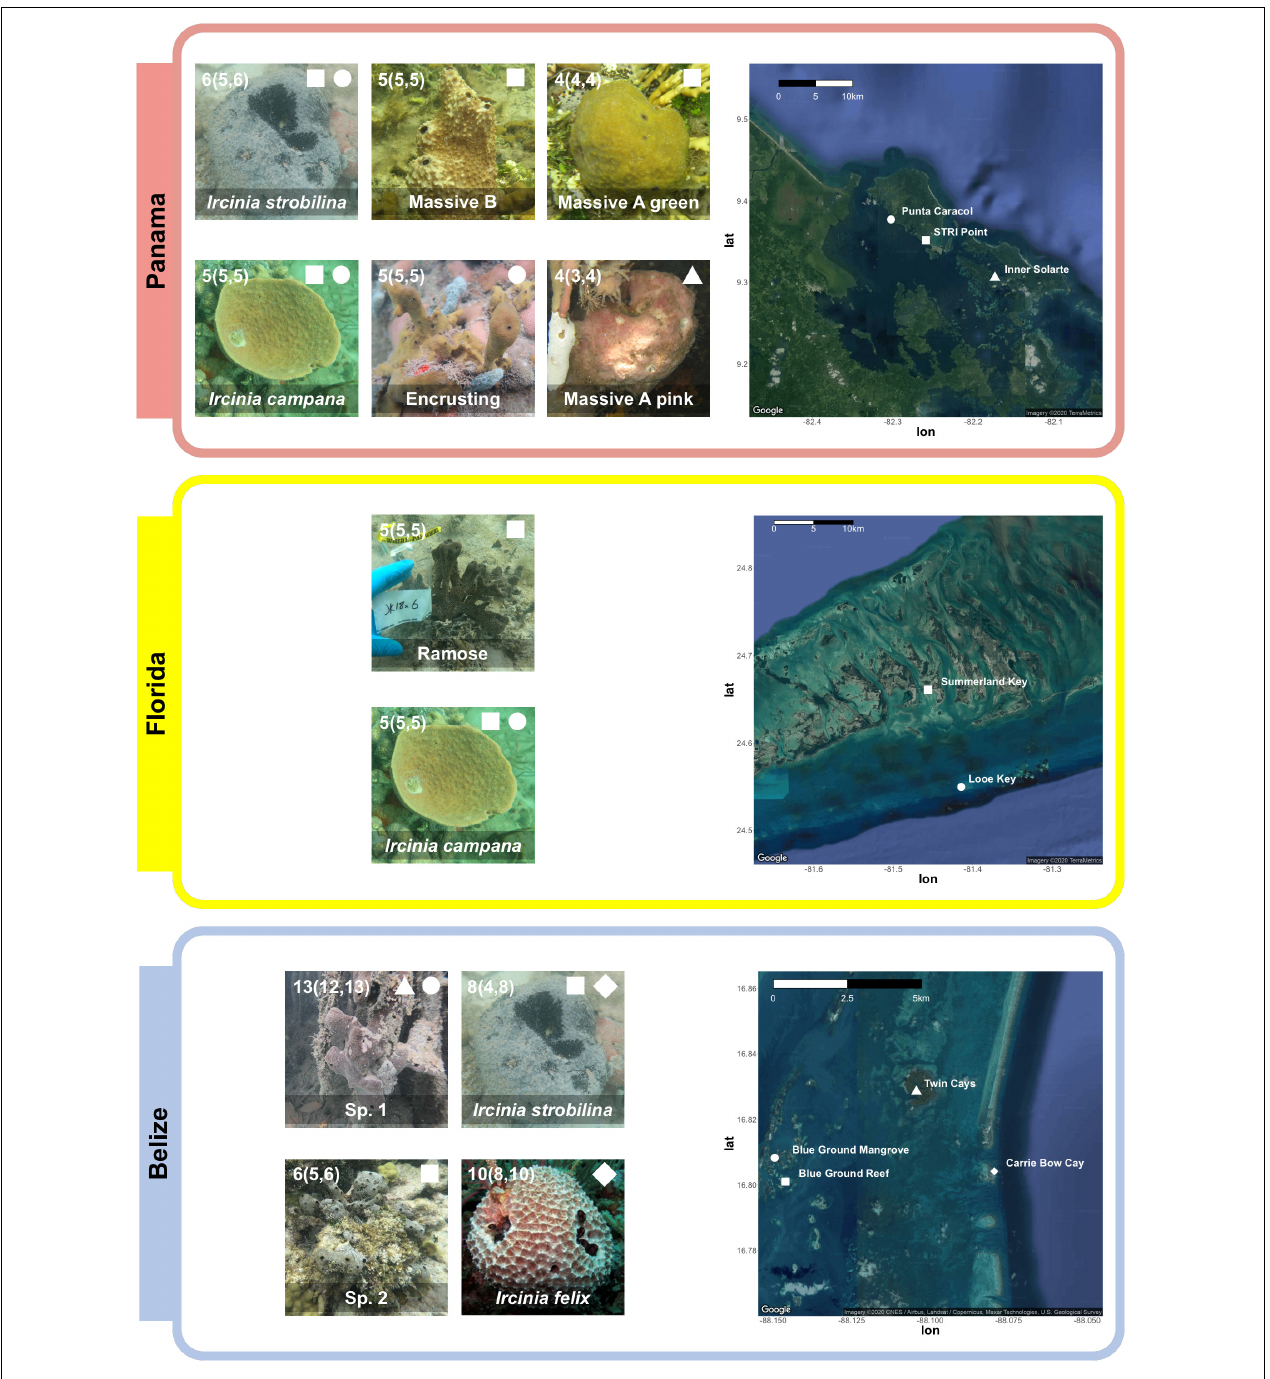
FIGURE 1 | Top : Four Panamanian growth forms were collected from three sites: Massive A pink was collected from Rhizophora prop roots at Inner Solarte, a network of mangrove hammocks; Massive A green and Massive B were collected from STRI Point, a Thalassia seagrass-dominated habitat; and Encrusting was collected from Punta Caracol, a coral patch reef. I. campana and I. strobilina specimens were also collected from STRI Point and Punta Caracol. Middle : specimens of a growth form (Ramose) and I. campana were collected from a seagrass bed on Summerland Key, Florida; two specimens of I. campana were also collected from Looe Key. Bottom : Two Belizean growth forms were collected from three sites: Sp. 1 specimens were collected from Rhizophora prop roots at the Twin Cays and from mangrove hammocks adjacent to the series of Blue Ground coral patch reefs; and Sp. 2 specimens were collected from the coral reefs at Blue Ground. Specimens of I. strobilina were collected form the same patch reef inhabited by Sp. 2 and also from the forereef at Carrie Bow Cay, and I. felix specimens were collected from the Carrie Bow Cay forereef. I. felix photo credit: Patrick Erwin (Hentschel et al., 2012). Numbers in each photograph correspond to sample size, reported as total sample size (samples in 2bRAD dataset, samples in 16S dataset), less the transcriptomic sample of the Ramose growth form. A complete sampling overview can be found in Supplementary Table 1 .